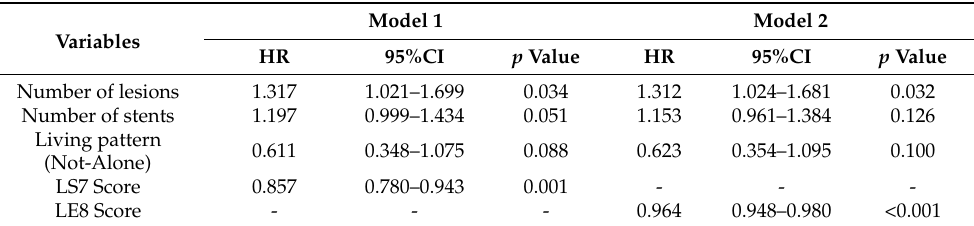
Table 2. Cox regression of the Life’s Simple 7 and Life’s Essential 8 on the prediction of MACEs in 2 years ( n = 339).